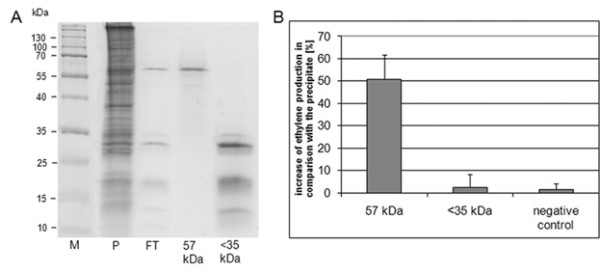
Elicitor activity of identified P. halstedii 57 kDa protein. Figure (A) shows a 13% SDS-PAGE of the P. halstedii protein purification. Lane 2 (P) displays the ammonium sulphate precipitate, lane 3 (FT) shows the purified proteins of the flow-through, lane 4 (57 kDa) displays the gel extraction section from lane 3 at Mr 50-70 kDa and lane 5 (<35 kDa) shows the gel extraction section from lane 3 at Mr below 35 kDa. The diagram (B) shows the effect of the extracted proteins of the flow-through to the ethylene induction of sunflower leave-disks 3 h after infiltration. The three columns display the activity of the gel extraction section of the 57 kDa protein (lane 4, 57 kDa), the gel extraction section of proteins <35 kDa (lane 5, <35 kDa) and the negative control. M represents marker (n = 3).